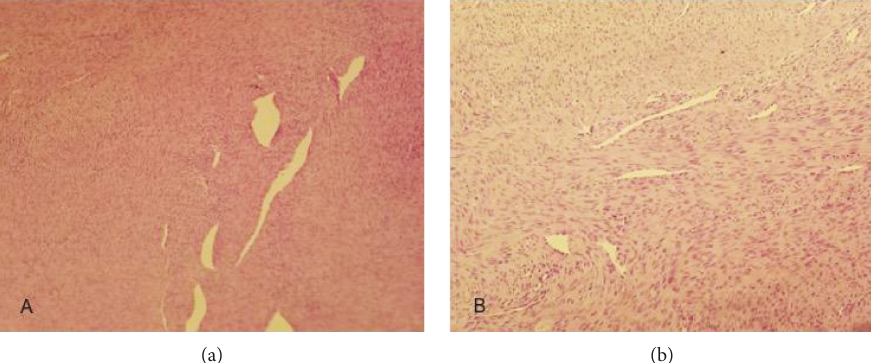
Figure 2: Proliferation of spindle or oval cells, arranged in a fascicular fashion with ropey collagen fi bres, associated with variably dilated blood vessels often displaying staghorn-like appearance. Mitotic fi gures were few ((a) × 100, (b) × 200).